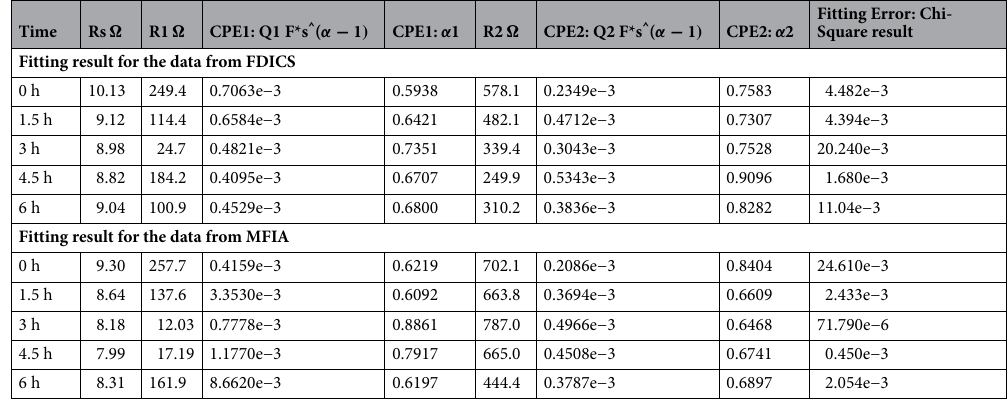
Table 6. The fitting result of EIS data from the FDICS and